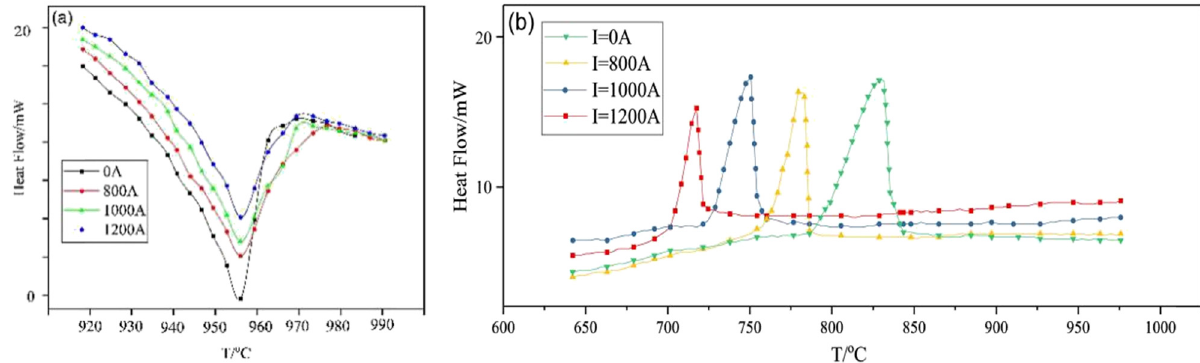
Figure 4: ( a ) Heating curves and ( b ) cooling curve of Cu – 37.4 wt% Pb alloys with di ff erent ECP treatments.